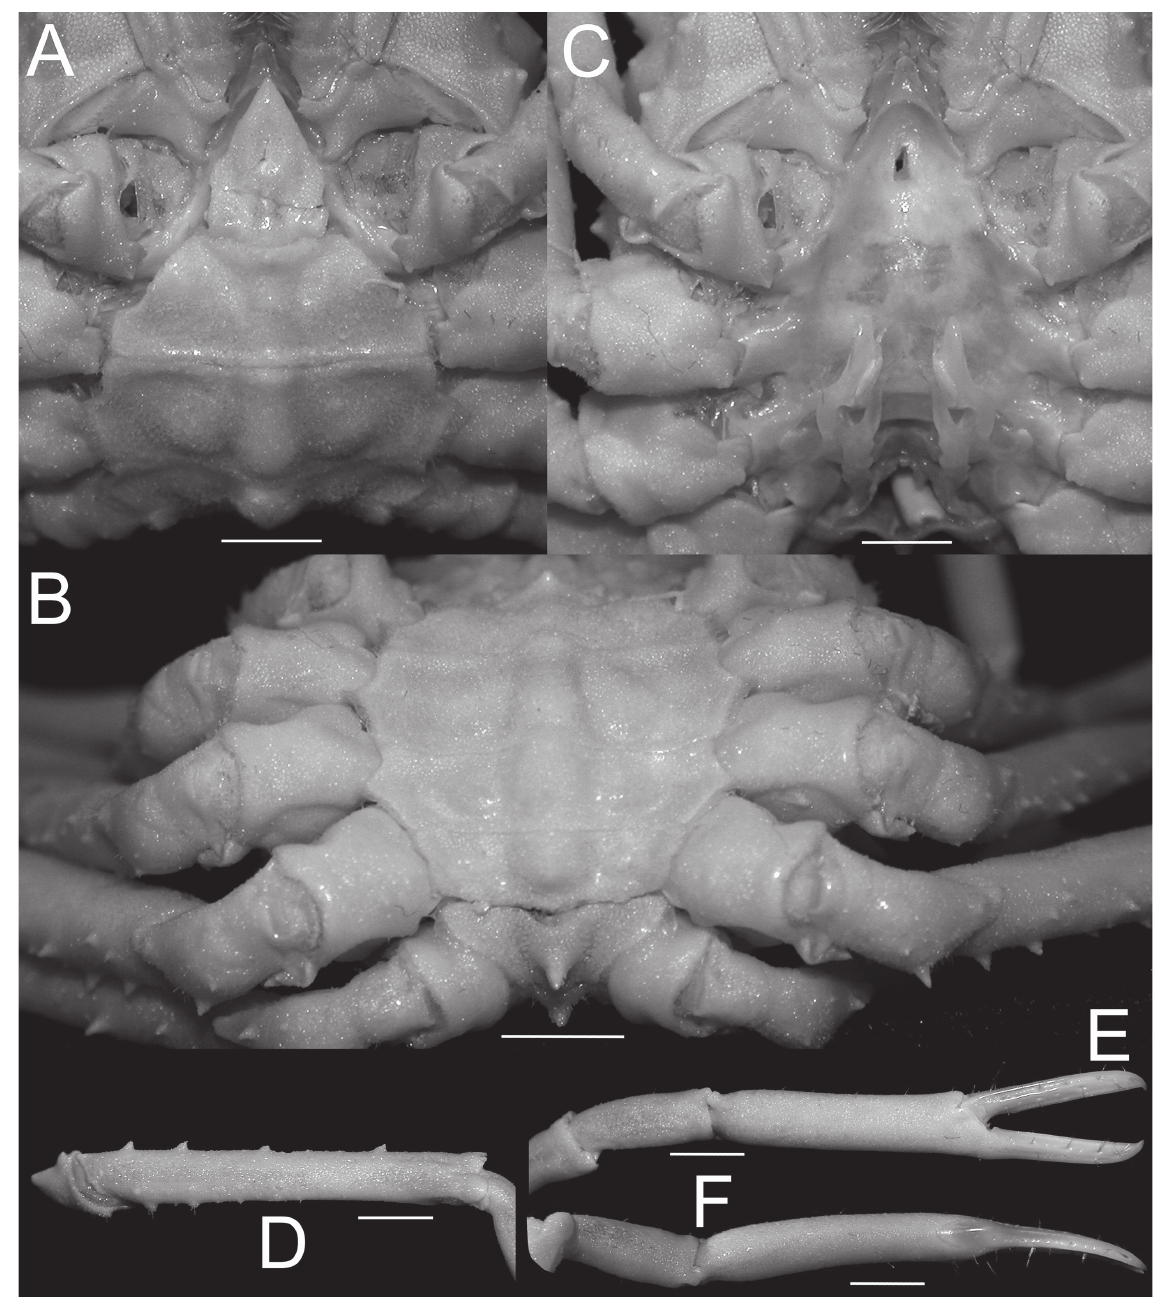
Fig. 7. Moloha alisae Guinot & Richer de Forges, 1995. Holotype, ♂ (cl 36.1 mm, cw 29.7 mm) (MNHN-IU-2008-11077), Seychelles. A . Telson and pleonal somites 5 and 6. B . Pleonal somites 2–6. C . Sternopleonal cavity. D . Merus and carpus of right cheliped. E . Outer view of right chela. F . Ventro- marginal view of right chela. Scale bars = 5